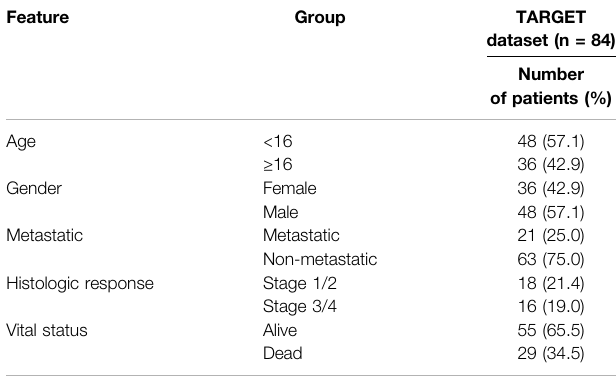
TABLE 1 | Clinical features of all